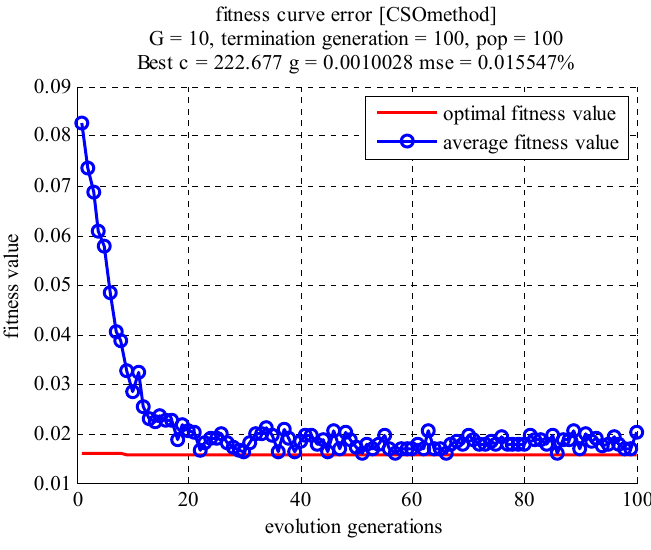
Figure 7. The fitness curve of chicken swarm optimization algorithm.